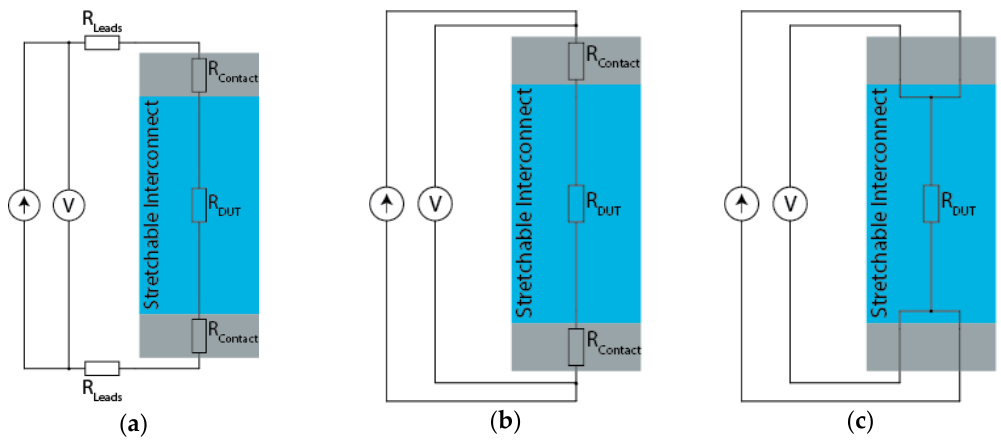
Figure 10. Measurement setups for resistance measurement: ( a ) two-wire setup affected by lead and contact resistance; ( b ) quasi four-wire setup affected by the contact resistance; and ( c ) true four-wire setup that eliminates the effect of lead and contact resistance.